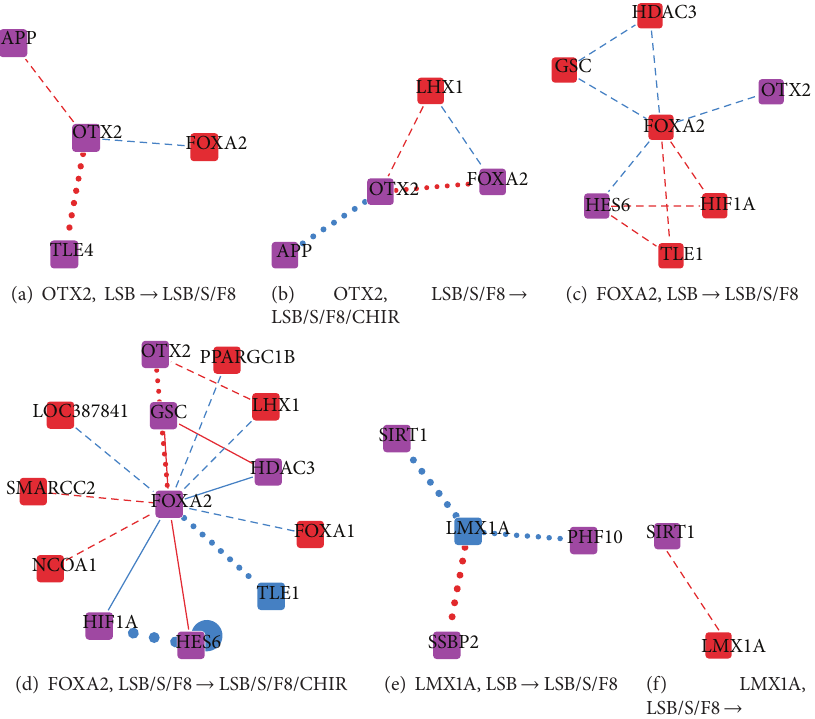
Figure 2: The interaction activity variations of well-known proteins OTX2, FOXA2, and LMX1A in the IDNs at two differentiation stage transitions. (a) Interaction activity variation of OTX2 from LSB to LSB/S/F8; (b) of OTX2 from LSB/S/F8 to LSB/S/F8/CHIR; (c) of FOXA2 from LSB to LSB/S/F8; (d) of FOXA2 from LSB/S/F8 to LSB/S/F8/CHIR; (e) of LMX1A from LSB to LSB/S/F8; (f) of LMX1A from LSB/S/F8 to LSB/S/F8/CHIR. (Nodes: red indicates disappearance at the previous stage and appearance at the later stage. Blue indicates appearance at the previous stage and disappearance at the later stage. Purple indicates appearance under both conditions. Edges: red indicates an enhancing interaction (i.e., + → ++, −− → − , 0 → +, and − → 0). Blue indicates an attenuating interaction (++ → +, − → −− , + → 0, and 0 → − ). A solid edge represents appearance under both conditions. A dashed edge represents disappearance under the previous condition and appearance under the later condition. A dotted edge represents appearance under the previous condition and disappearance under the later condition. The width of the edge represents the magnitude of the interaction activity